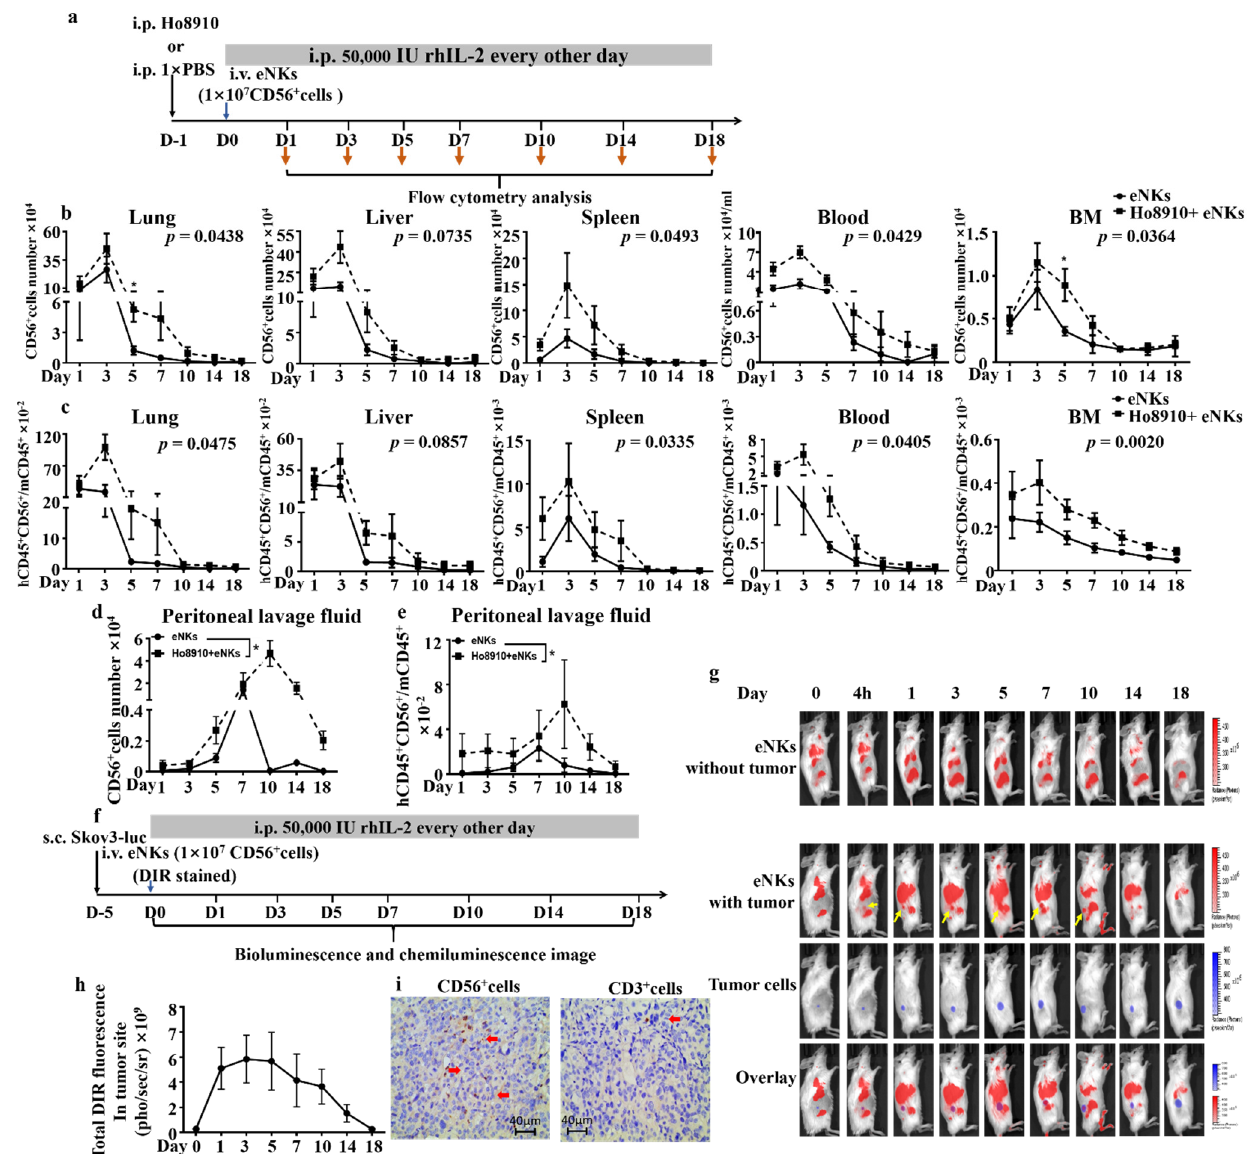
Figure 3. eNKs showed enhanced proliferation, lifespan, and tumor co-localization in xenograft ovarian tumor-bearing NCG mice. ( a ) eNKs were adoptively transferred to ovarian tumor- or non-tumor-bearing NCG mice. ( b ) Total human CD56 + cell numbers were determined by automatic cell counter at the indicated times. ( c ) Flow cytometry analysis of the persistence and distribution of adoptively transferred CD56 + cells in lung, liver, bone marrow, spleen, and blood. ( d , e ) Flow cytometry and automatic cell counter analysis of the percentage and total human CD56 + cells in mouse peritoneal lavage fluid after cell injection at the indicated times. ( f ) Experimental design and timeline of Skov3-luc injection and eNK co-localization assays. ( g ) Bioluminescence and chemiluminescence imaging showing the tumor and transferred eNKs localization at the indicated times. ( h ) DIR signal was quantified via chemiluminescence at the indicated times. ( i ) Immunohistochemical imaging of human CD56 + and CD3 + cells in tumor tissue. Results are representative of at least three independent experiments. All data were analyzed by two-tailed paired Student t -test. Data are represented as mean ± SD. * p < 0.05.